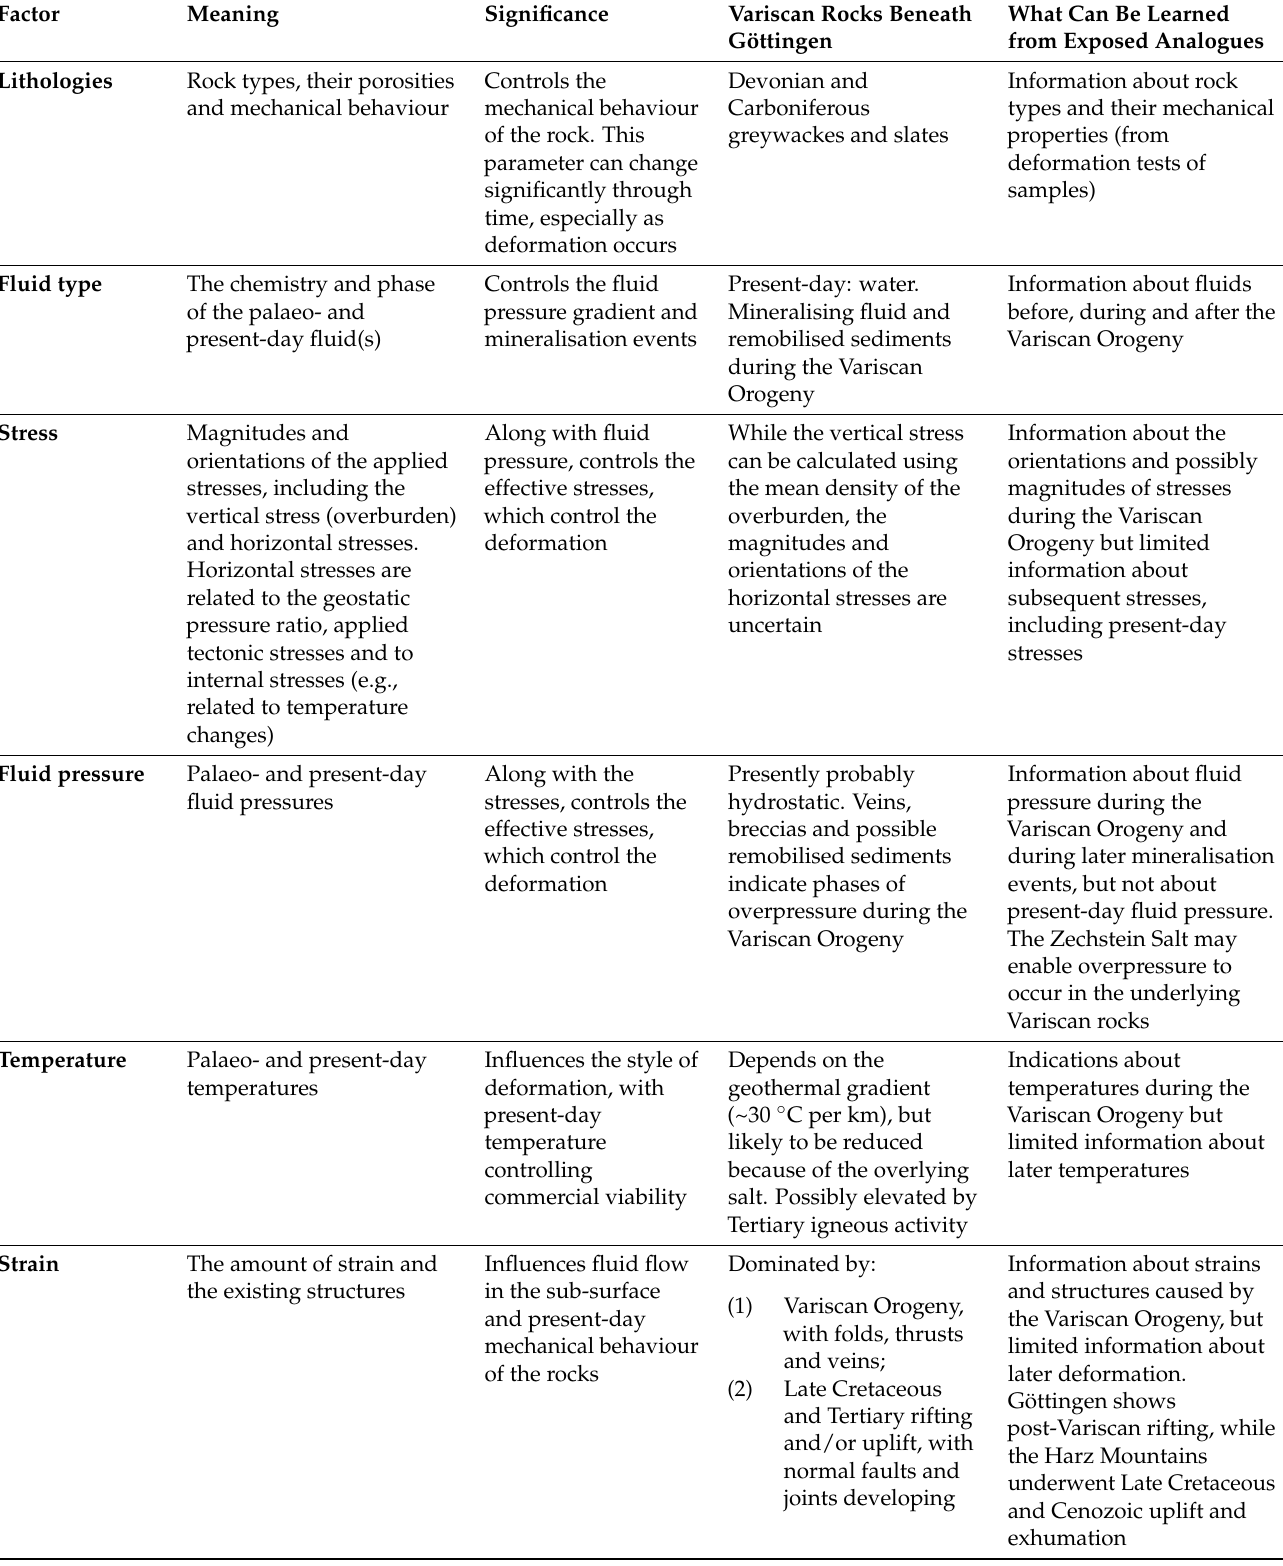
Table 1. Key parameters that control rock deformation with predictions for the Variscan rocks beneath Göttingen and comments on what can and cannot be learnt from the exposed analogues in the Harz Mountains. For a list of parameters to be characterised in a geothermal reservoir, see